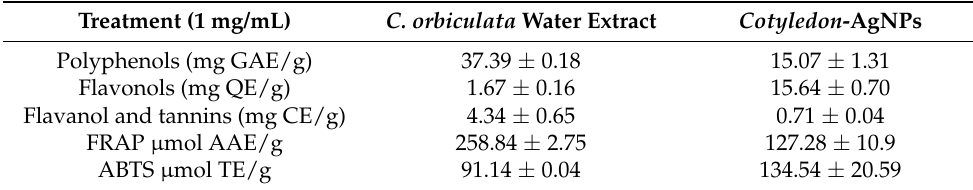
Table 1. Phytochemical analysis and antioxidant